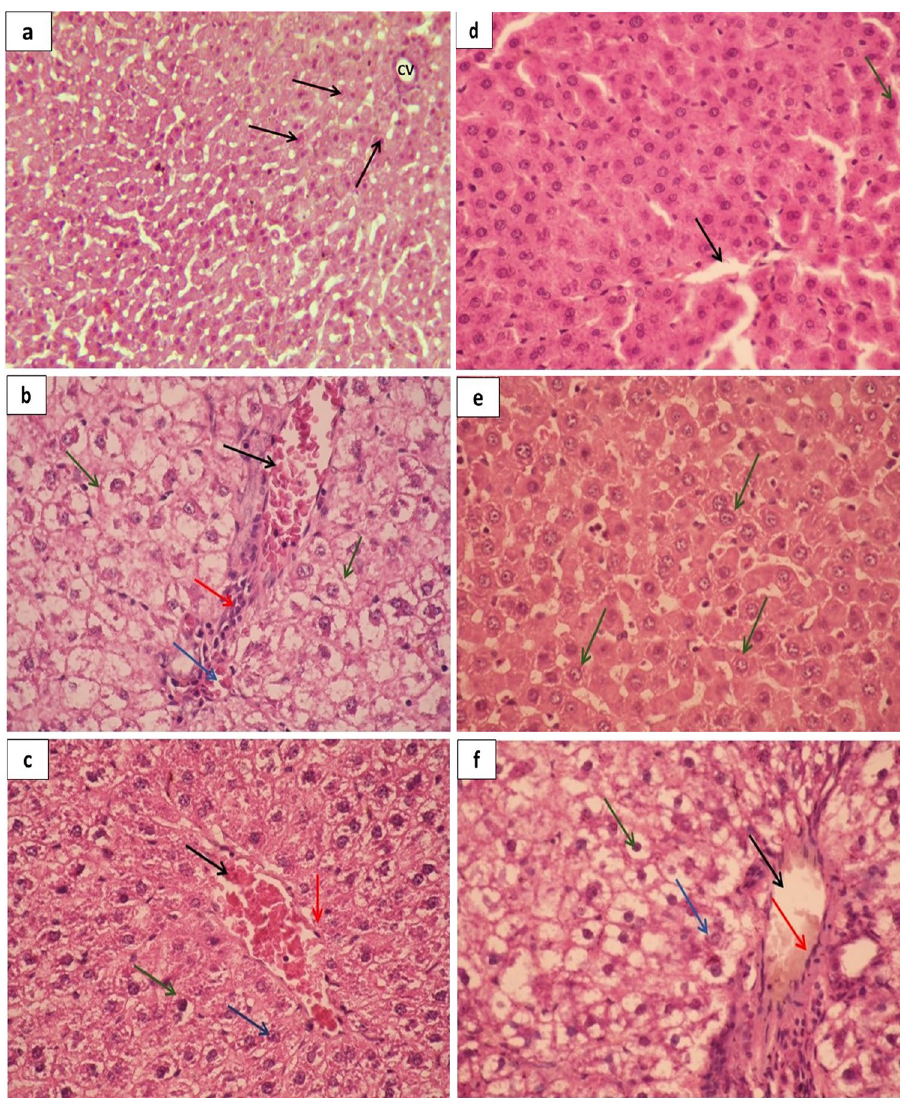
Figure 9. Histopathological study of the liver. ( a ) Photomicrograph of control group displaying liver tissue with normal hepatocytic cords (Black arrows) crowded around a clear central vein (CV) (H&E stains, X400). ( b ) Photomicrograph of HFD/STZ-induced shows a marked dilated hemorrhage portal tract, bile duct (Black arrow), dilated hemorrhage central vein (Blue arrow), and edema. Besides, few infiltrating lymphocytes (Red arrow), and dilation of the sinusoid were seen (vacuolar and hydropic degeneration), which indicate the fatty degeneration of the liver (Green arrows) (H&E stain, X400). ( c ) Photomicrograph of HFD/STZ + Cur shows crowded hepatocyte around the congested portal tract (Black arrow) with few fibrotic cells (Red arrow). Most hepatocytes with rounded nuclei and vacuolated cytoplasm (Green arrows). Many karyolysis hepatocytes and necrotic one was seen (Blue arrow) (H&E stains, X400). ( d ) Photomicrograph of HFD/STZ + CurNPs-10 shows a mild dilated portal tract (Black arrow), the hepatocytes are crowded and have small dark nuclei (Green arrows) (H&E stains, X400). ( e ) Photomicrograph of HFD/STZ + CurNPs-50 shows the necrotic changes of hepatocytes (dark condensed/ pyknotic nucleus) (Green arrows) (H&E stains, X400). ( f ) Photomicrograph of HFD/STZ + ZnSO 4 shows marked dilated portal tract (Black arrow) surrounded with few fibrotic cells (Red arrow), dilated bile duct, and crowded hepatocytes were appeared with round nuclei and vacuolated cytoplasm (Green arrows). With a few necrotic and pyknotic one was seen (Blue arrow) (H&E stains, X400). ( g ) Photomicrograph HFD/STZ + ZnONPs-10 shows marked dilated three portal tracts and bile with the absence of the fibrotic cells (Black arrows). Reorganized hepatocytes architecture with dark rounded nuclei with homogenous non-vacuolated cytoplasm was seen (Green arrows). Few necrotic hepatocytes (Blue arrows) and mildly dilated sinusoid with Kuffer’s cell were seen (Red arrows) (H&E stains, X400). ( h ) Photomicrograph of HFD/STZ + ZnONPs-50 shows marked recovering of hepatocytes were appeared with round nuclei containing prominent nucleoli and homogenous non-vacuolated cytoplasm (Black arrows). Few necrotic hepatocyte and pyknotic one was seen (Blue arrows) (H&E stains, X400). ( i ) Photomicrograph of HFD/STZ + MT shows marked dilated and congested portal tract and bile duct surrounded with fibrotic cells (Black arrows). Proliferating hepatocytes were appeared with round nuclei and vacuolated cytoplasm (Blue arrows) (H&E stains,